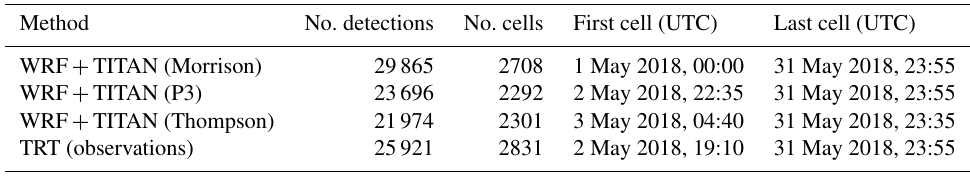
Table 4. Summary information for each dataset, showing the number of cell detections (cell–time combinations), number of cells, and first and last cell detection times.